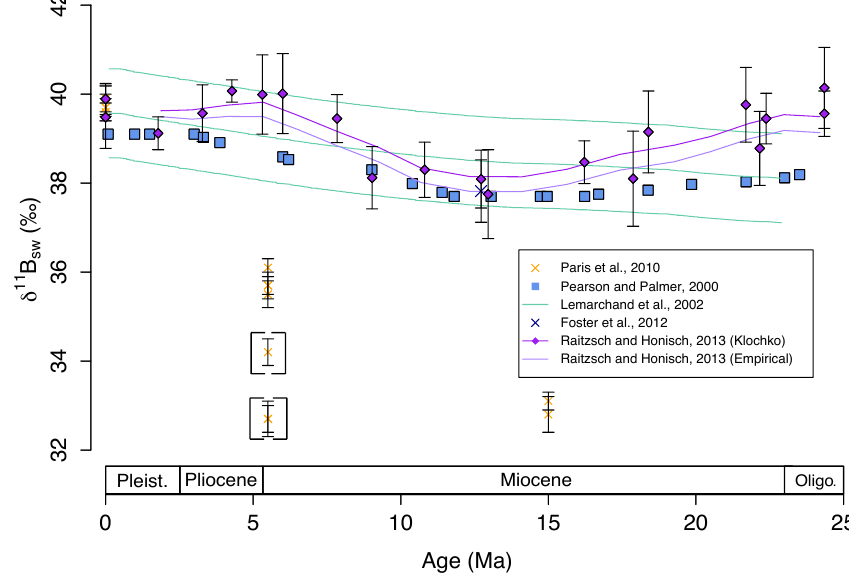
Figure 2. A compilation of published δ 11 B sw records. Seawater composition reconstructed from foraminifera depth profiles (light blue squares and dark blue crosses) from Pearson and Palmer (2000) and Foster et al. (2012) respectively; numerical modelling (green line), with additional green lines showing ± 1‰ confidence interval (Lemarchand et al., 2000); benthic δ 11 B (purple diamonds and dark purple line showing 5-point moving average uses the fractionation factor of Klochko et al., 2006, light purple line showing 5-point moving average uses an empirical calibration) from Raitzsch and Hönisch (2013); and halites (orange crosses) from Paris et al. (2010). The orange crosses in brackets were discarded from the original